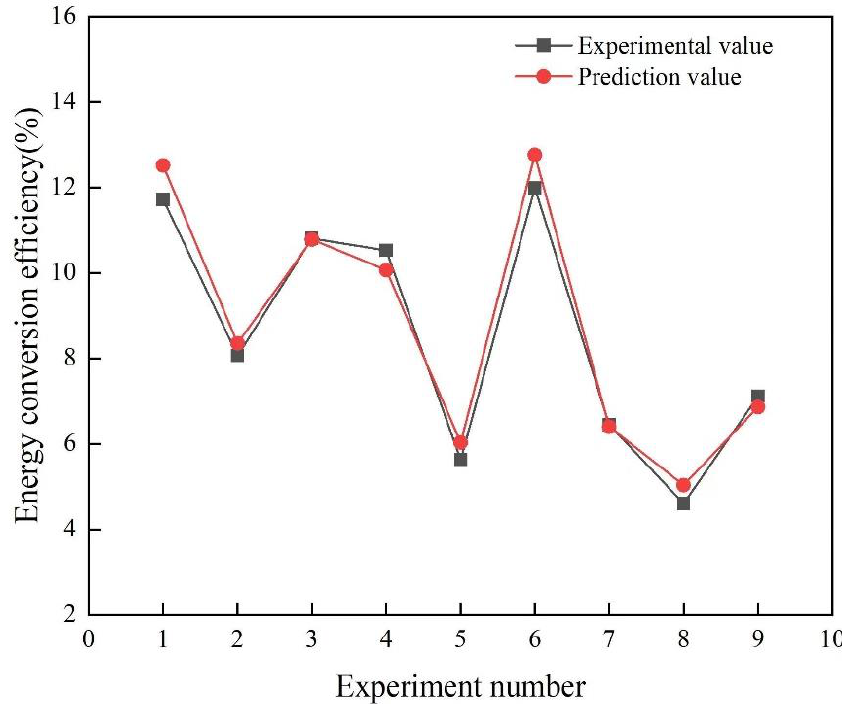
Figure 3. Polarization curves.